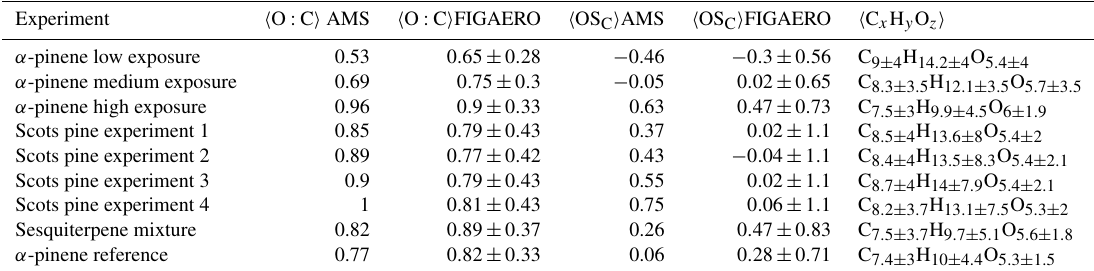
Figure 4. Mass spectra integrated over the whole FIGAERO desorption cycle for each experiment. Each spectrum is normalized to the peak height of the most abundant ion. Table 3. Average O : C ratio, OS C and chemical composition from each experiment calculated from AMS and FIGAERO data. Values calculated from FIGAERO are weighted by the integrated signal strength. All FIGAERO data are shown with standard deviation to highlight the spread of different compositions in the mass